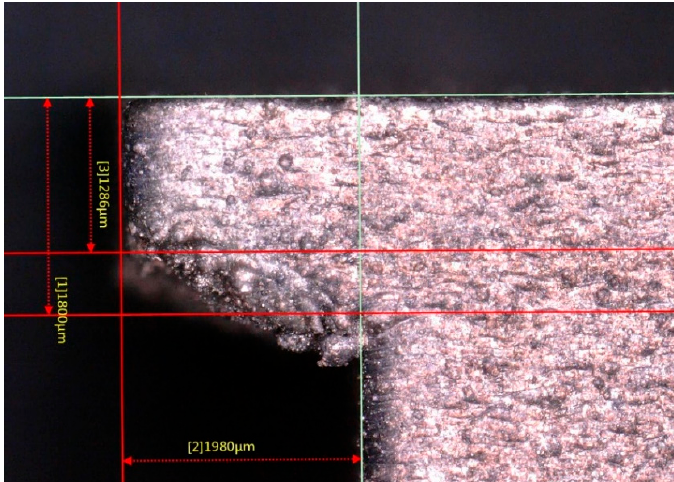
Figure 4. Partial enlargement diagram of the sample.